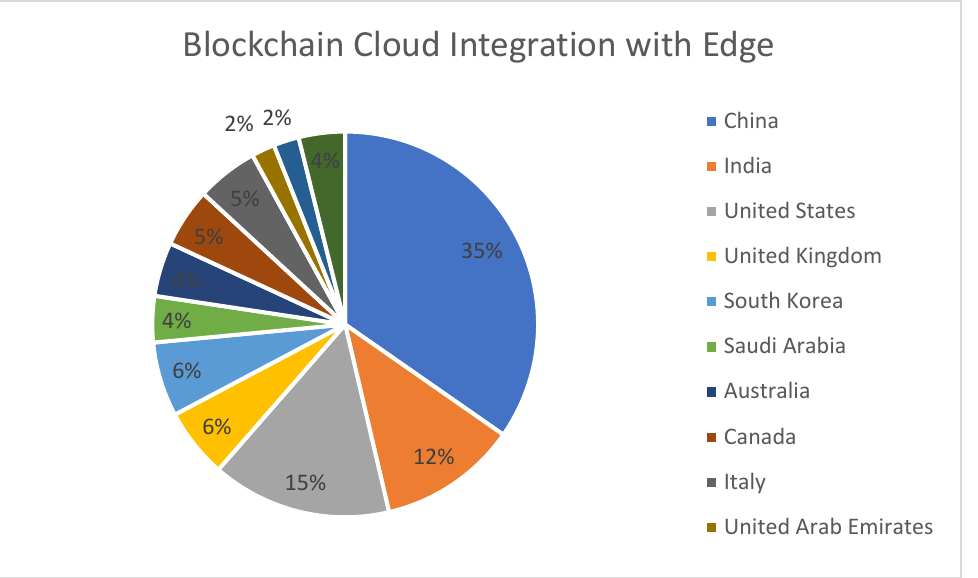
Figure 19. Region-specific publication distribution for Blockchain–Cloud integration with Edge Computing. Figure 20 represents the region-wise publication distribution for works concerning the use of Blockchain–Cloud integration along with Deep